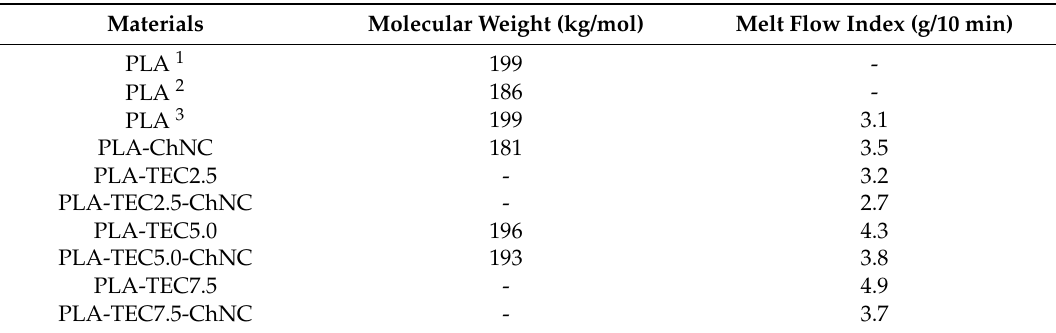
Table 2. Molecular weight ( M w) and melt flow